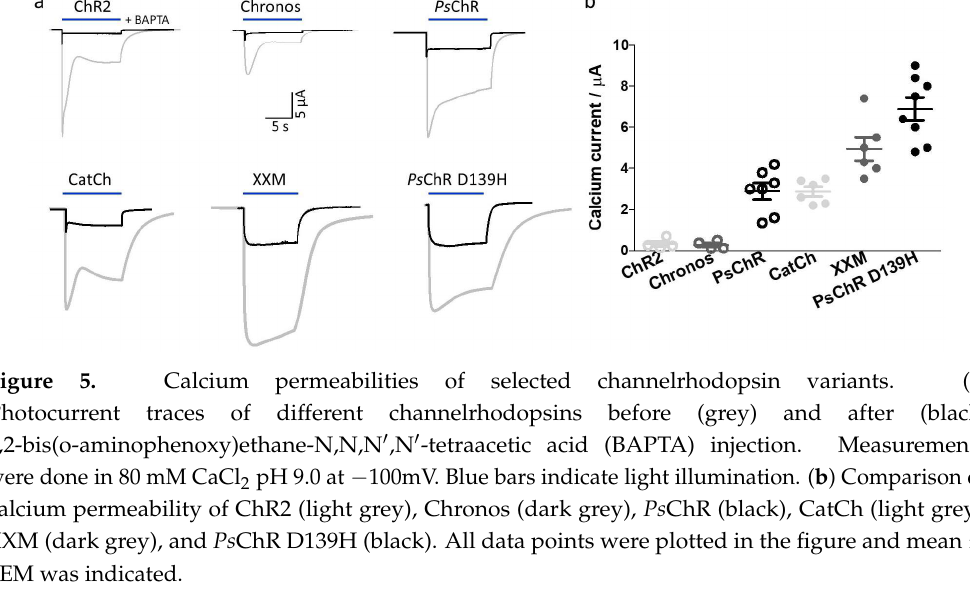
Table 1. Basic properties of ChR2, Ps ChR, and Chronos variants.